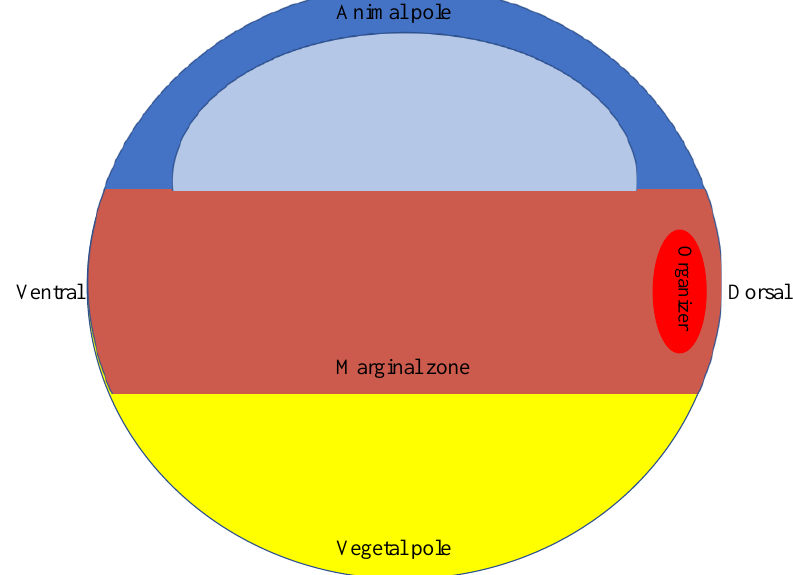
Figure 1. Diagram of Xenopus laevis embryo during early gastrulation. During gastrulation, the three primary germ layers, endoderm, mesoderm, and ectoderm, begin to differentiate. The vegetal pole refers to the lower hemisphere of the embryo and will give rise to the endoderm. The marginal zone refers to the equatorial region of the embryo between the animal and vegetal poles and will give rise to the mesoderm. The mesoderm contains a dorsal organizer region which secretes Bone Morphogenetic Protein (BMP) antagonists. The animal pole refers to the upper hemisphere of the embryo which will give rise to the ectoderm. The drawing of the cavity in the animal hemisphere depicts the fluid-filled blastocoel. As described in the text of the review, foxI1e , along with many other germ layer-enriched factors, is expressed in the cells of the animal pole. chordin and goosecoid are expressed in the dorsal marginal zone. wnt8 is expressed ventrolaterally and brachyury is expressed throughout the marginal zone. VegT, an activator of nodal and nodal-like genes, is expressed in the cells of the vegetal pole.